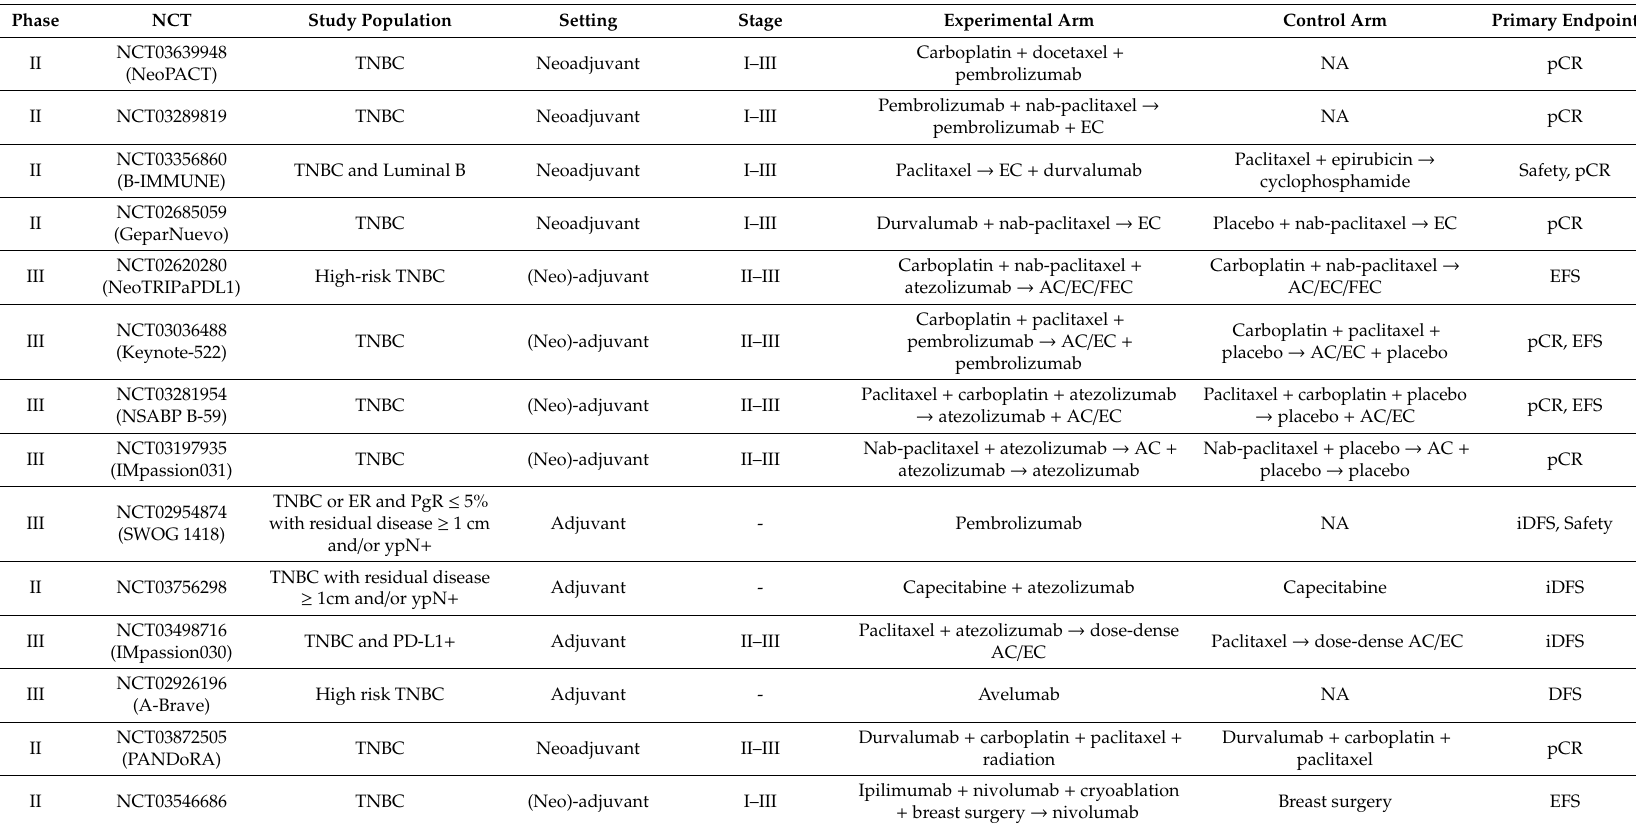
Table 3. Ongoing (neo)-adjuvant phases II–III clinical trials with immune checkpoint